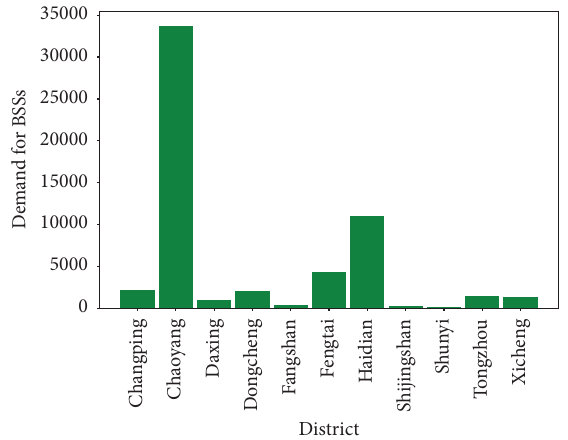
Figure 18: Demand for battery swapping in diferent administrative districts.